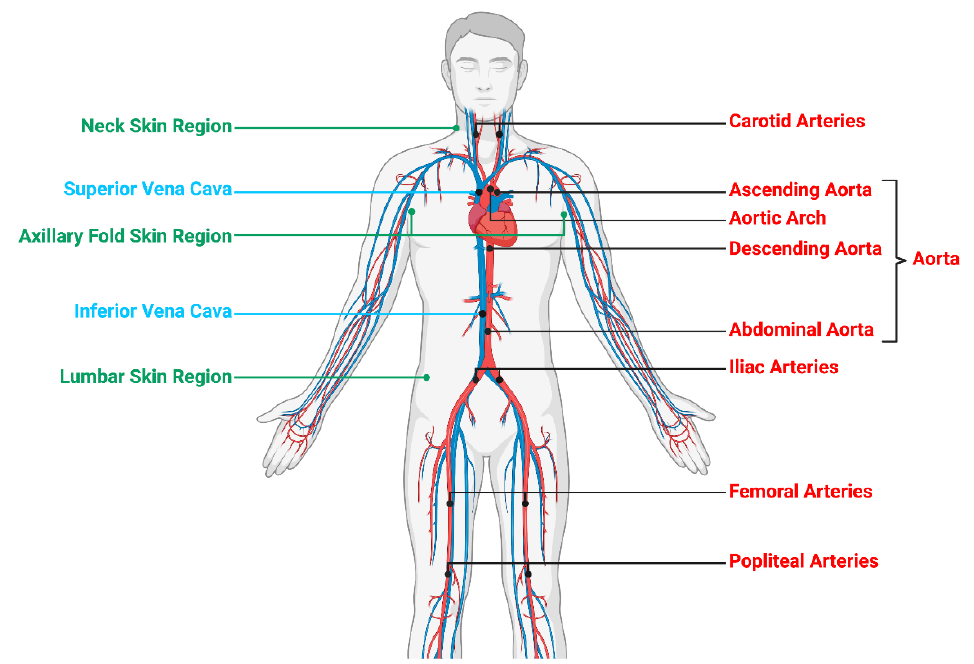
Figure 1. Whole-body 18F-FDG / 18F-NaF-PET / CT to assess subclinical arterial inflammation and active mineral deposition . Skin / arterial inflammation quantified as 18F-FDG SUVmax. Active mineral deposition quantified as 18F-NaF SUVmax. SUVmax was determined by manually drawing an individual ROI 1 cm 3 around the most fixed arterial segment. TBRmax in vascular system obtained by dividing artery SUVmax by vena cava (blood pool) SUVmax. SUVmax measured from ascending to abdominal aorta as mean total aorta (meanTBR) in addition to neck, axillary fold and lumbar skin regions.